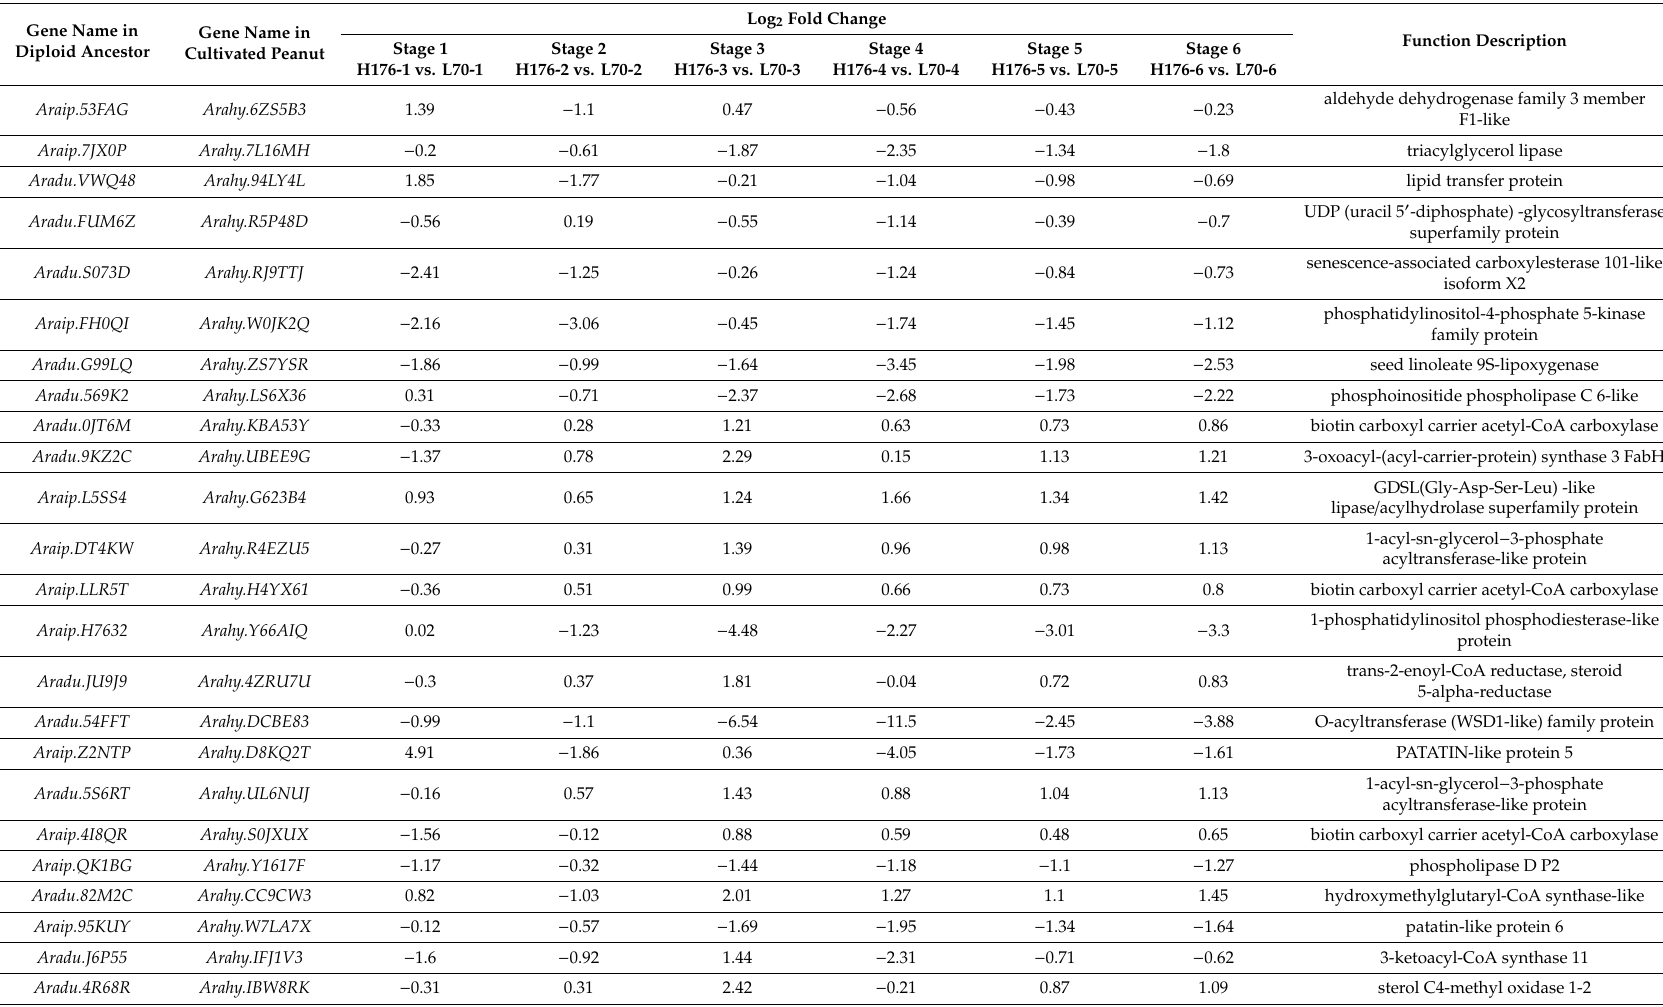
Table 2. Identification of lipid DEGs at each seed development stages in H176 vs.